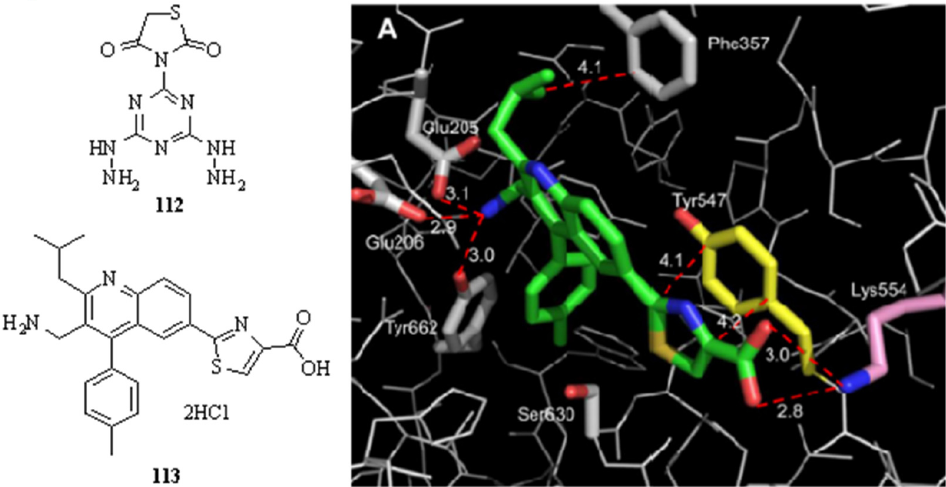
Figure 47. Structure of 1,3,5-triazine thiazolidine-2,4-dione 112 and thiazole based quinoline salt 113. (A) Docking study of compound 113 (green) with DPP-4 protein. Lys554 (pink), Tyr547 (yellow), and other amino acids (gray).